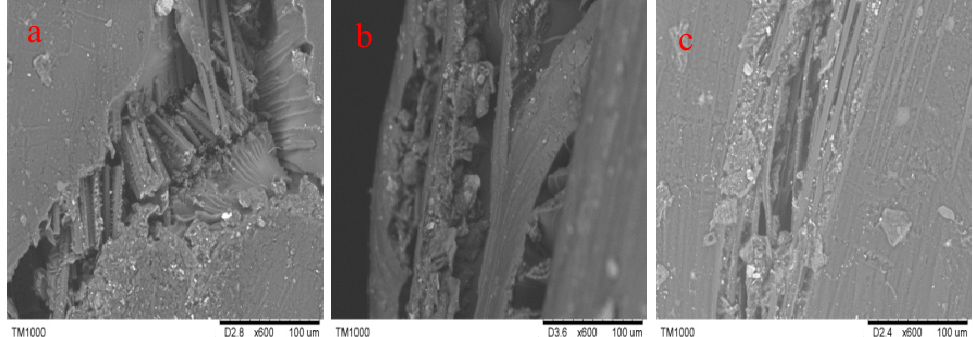
Figure 15. Electron microscopy of bending fracture of specimens at different temperatures ( a ) at room temperature; ( b ) 90 °C 0.25 h; ( c ) 110 °C 0.25 h.